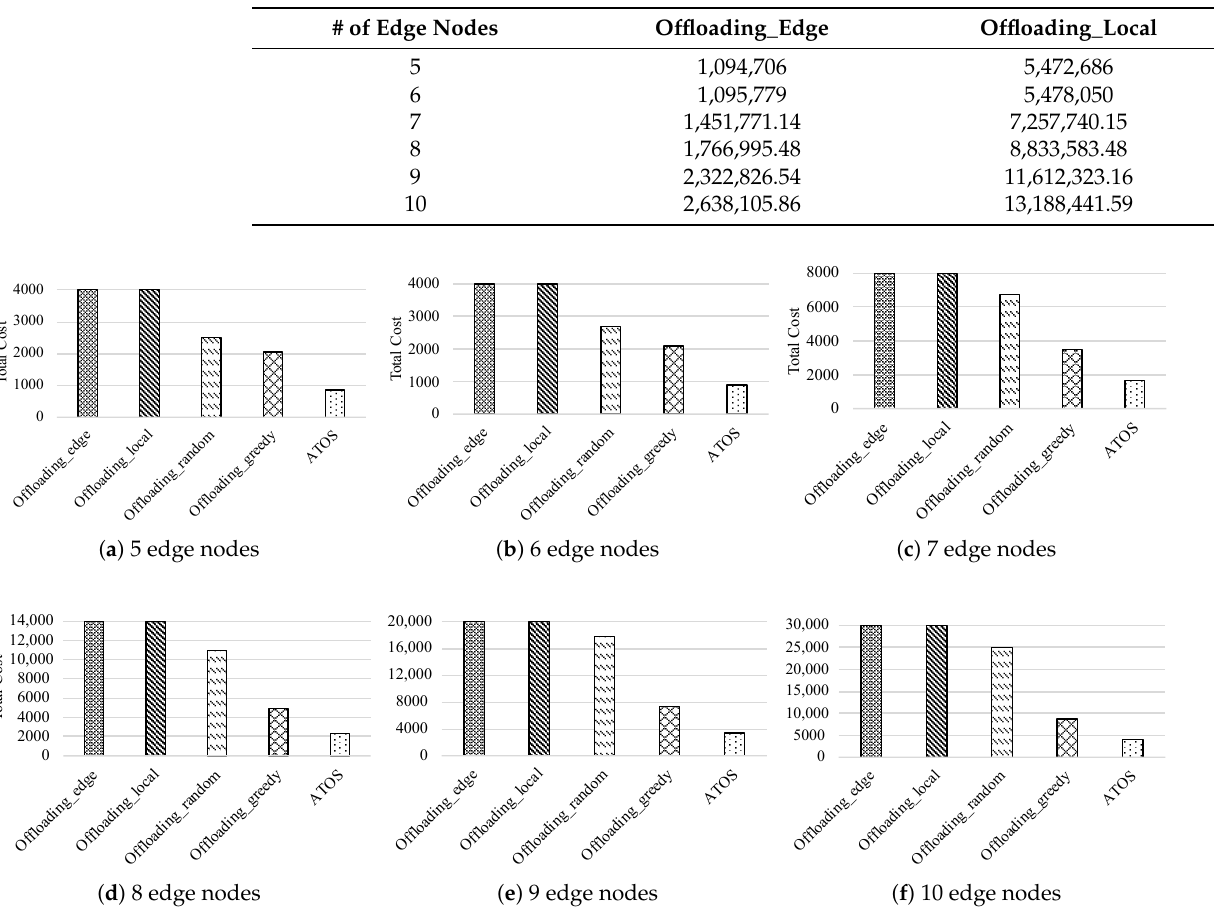
Table 4. Total costs of Offloading_edge and Offloading_local.